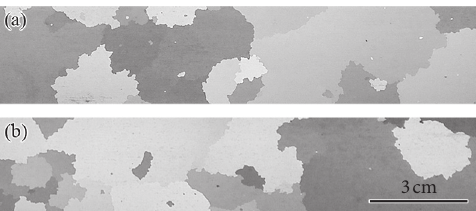
Figure 4: The microstructure of the central and edge seam regions in the core plane of SSS. (a) Central area. (b) Edge seam area.